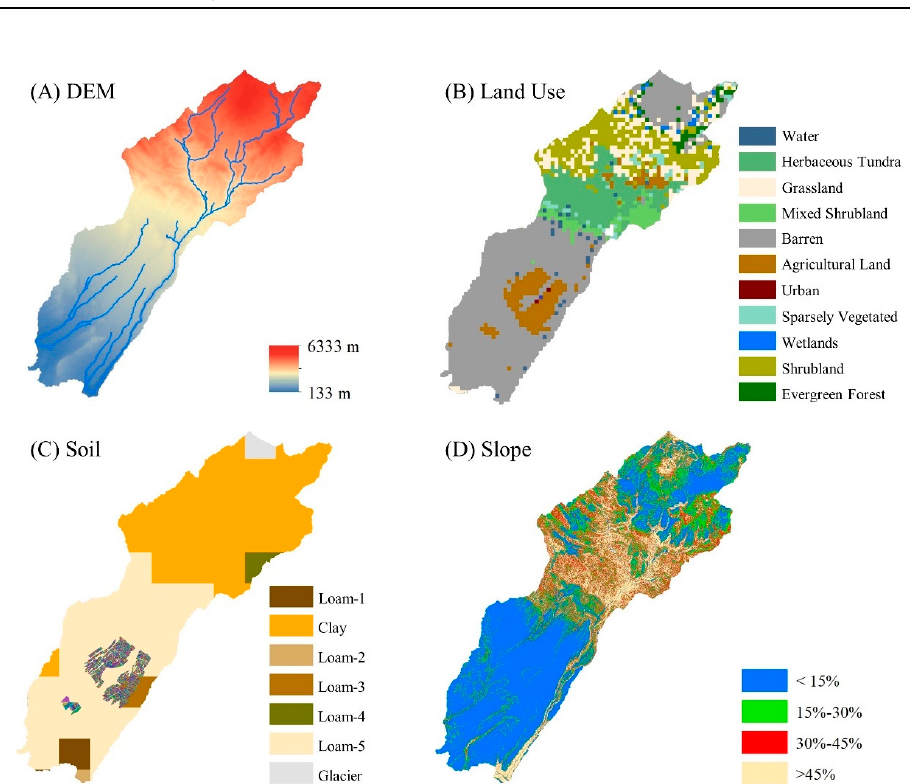
Figure 3. ( A ) Digital elevation model with 12.5-m resolution, ( B ) land cover map, ( C ) modified soil map, ( D ) slope map with 4 categories, for the study area.